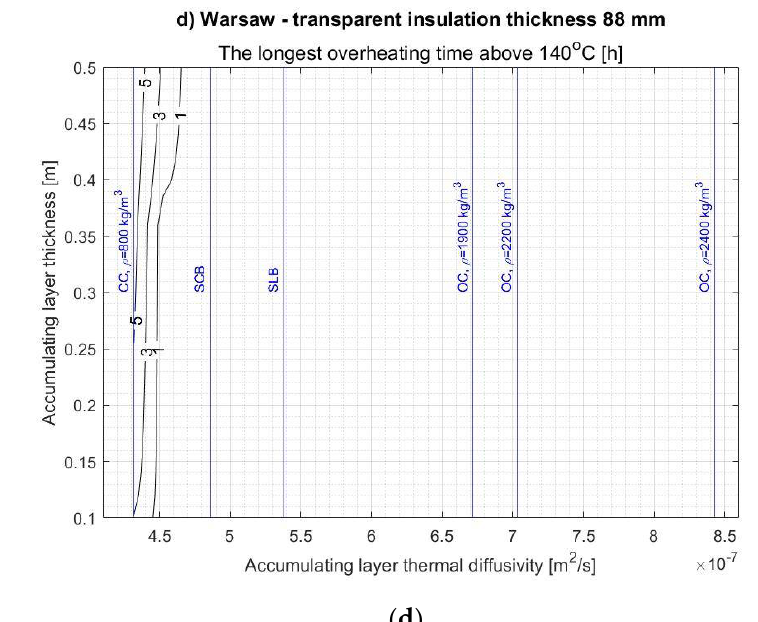
Figure A5. Contour graphs characterizing the SW basic parameters in a function of AL thermal diffusivity and thickness for the whole heating season: ( a ) the heat balance of the SW’s unit area, ( b ) the heating time, ( c ) the mean time lag of the maximum temperature on the absorber and SW’s internal surface during the day, ( d ) the longest overheating time above 140 °C in the TI. TI thickness: 88 mm. Location: Warsaw.